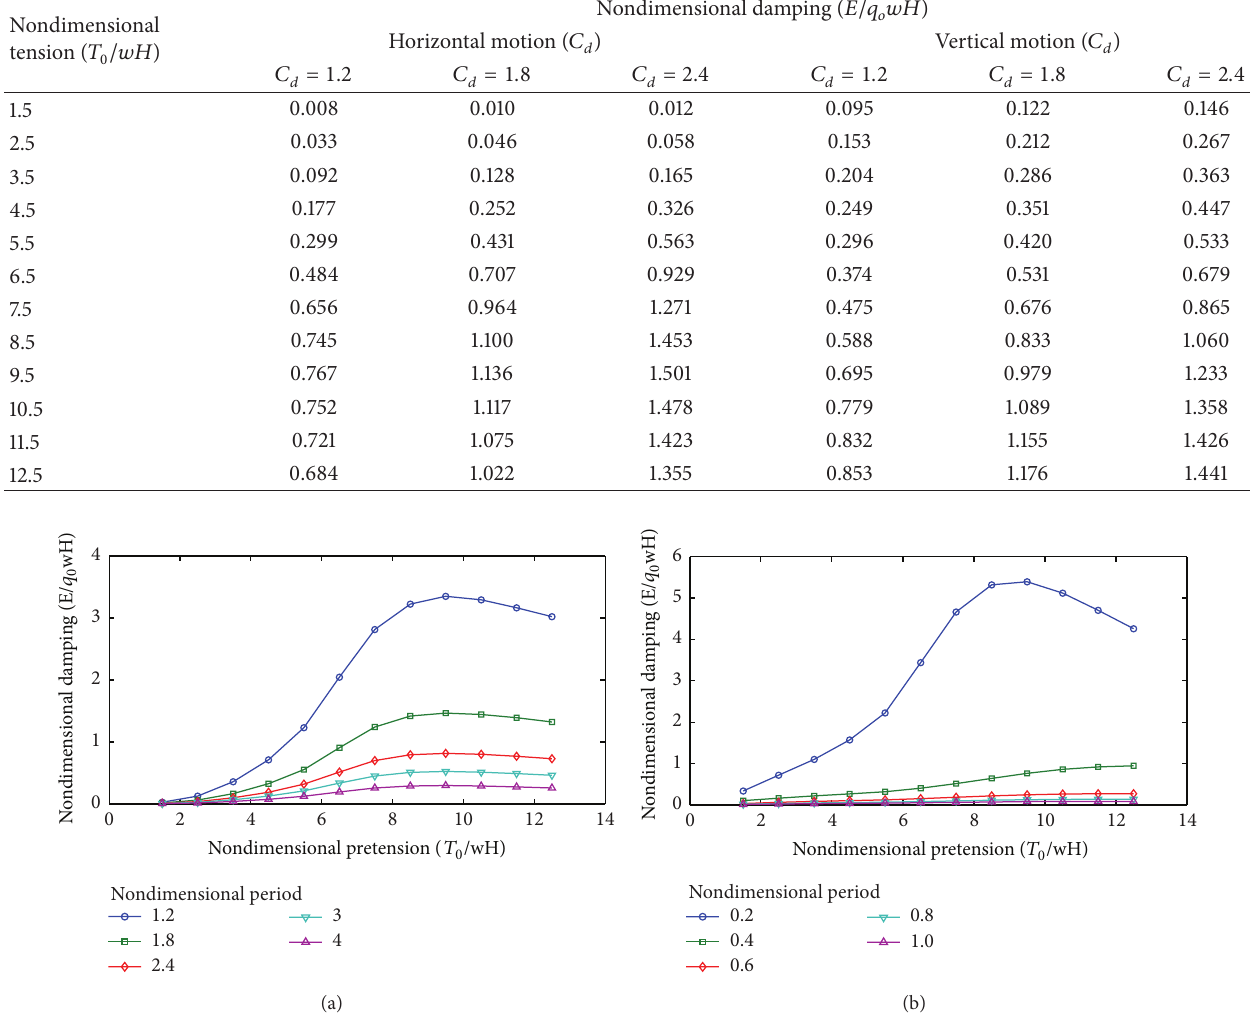
Figure 8: Variation of mooring line damping with excitation period. (a) Horizontal motions. (b) Vertical